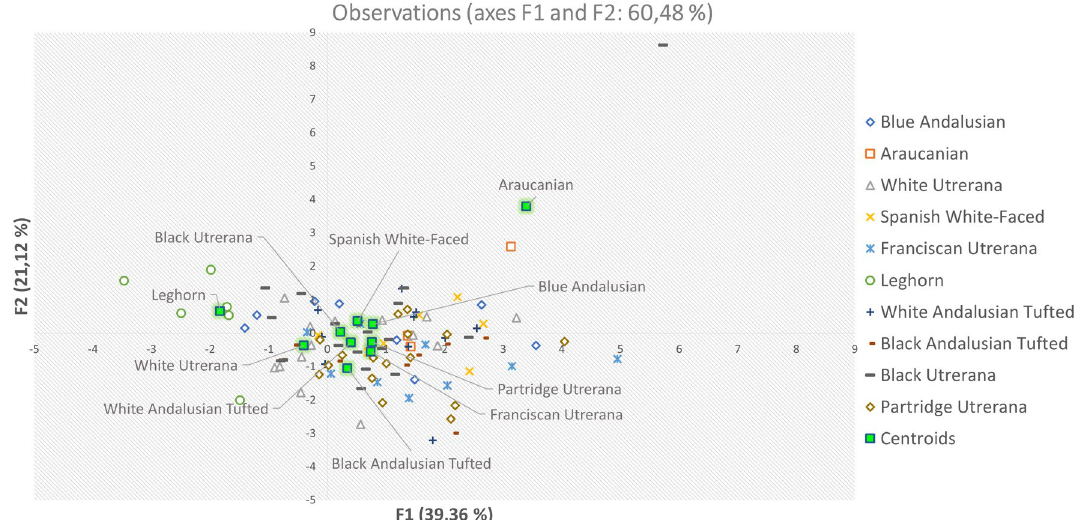
Figure 4. Territorial map depicting the eggs considered in the canonical discriminant analysis sorted across laying hen